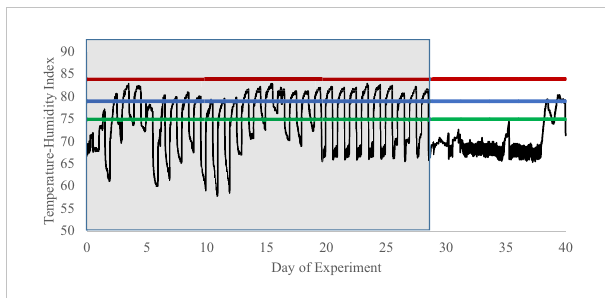
FIGURE 7 Experiment 2 temperature-humidity index of pen rooms during an experiment examining cell-mediated immune responses to endophyte and exit velocity treatments. Heifers were subjected in the fi rst 28 d of the experiment to heat stress and endophyte treatment. The heat stress component (P1, d0 to d29; represented by shaded portion) was removed on d29 and rooms remained at thermoneutral for the duration of the study. Due to logger failure, only 39 of 56 days within the experimental period are available for graphical representation. Additionally, mechanical failure throughout the experiment caused a deviation from the designed THI protocol. However, during the heat stress period (d0 to d29), temperatures cycled above the danger and below the alert heat stress thresholds described by Hahn (1999). Alert = green line, Danger = blue line, Emergency = red line.